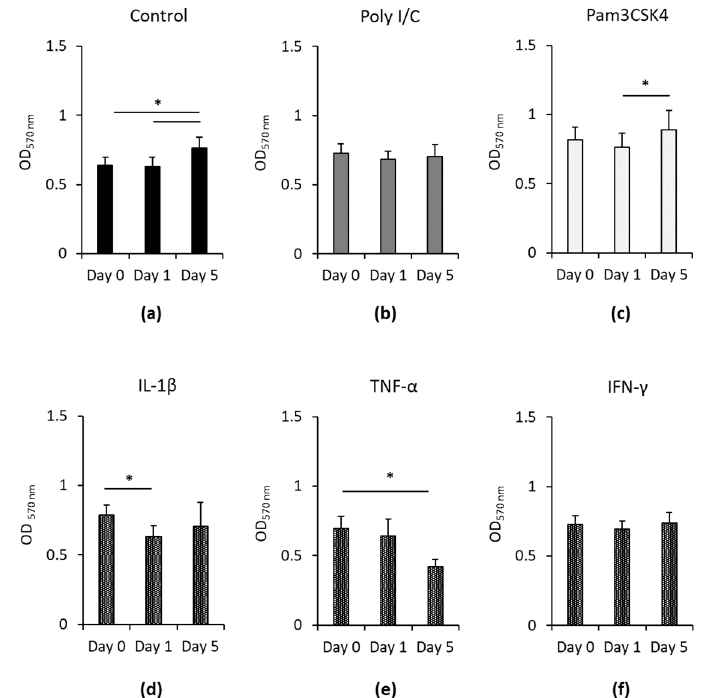
Figure 1. Continuing effect of Poly I/C, Pam3CSK4, IL-1 β , TNF- α and IFN- γ on the hPDLSCs’ viability. Primary hPDLSCs were stimulated with 1 µg/mL Poly I/C ( b ), 1 µg/mL Pam3CSK4 ( c ), 5 ng/mL IL-1 β ( d ), 10 ng/mL TNF- α ( e ) or 100 ng/mL IFN- γ ( f ) Untreated hPDLSCs served as control